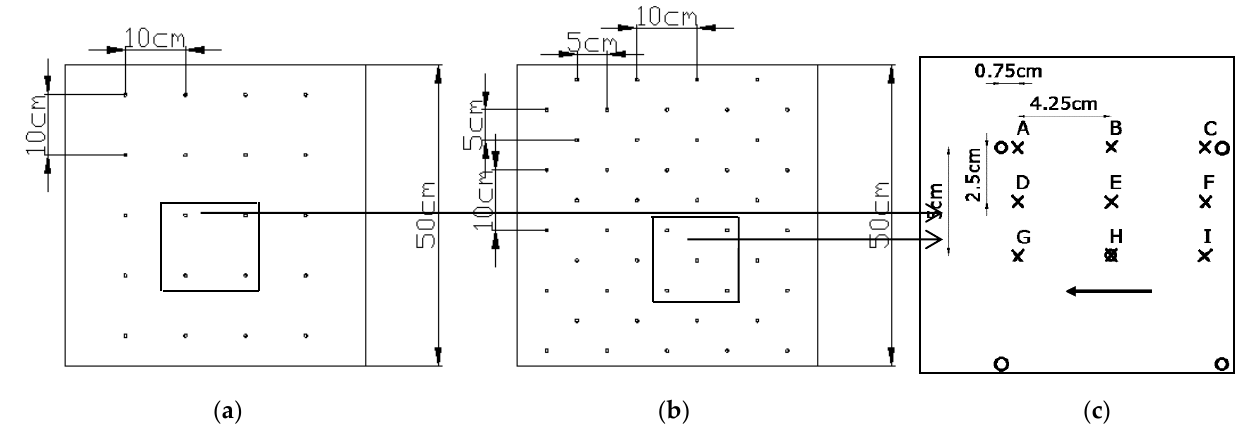
Figure 3 [M7] . Vegetation patterns ( a ) parallel at 100 stems/m 2 and ( b ) staggered at 200 stems/m 2 ; Figure 3. Vegetation patterns (a) parallel at 100 stems/m 2 and ( b ) staggered at 200 stems/m 2 ;